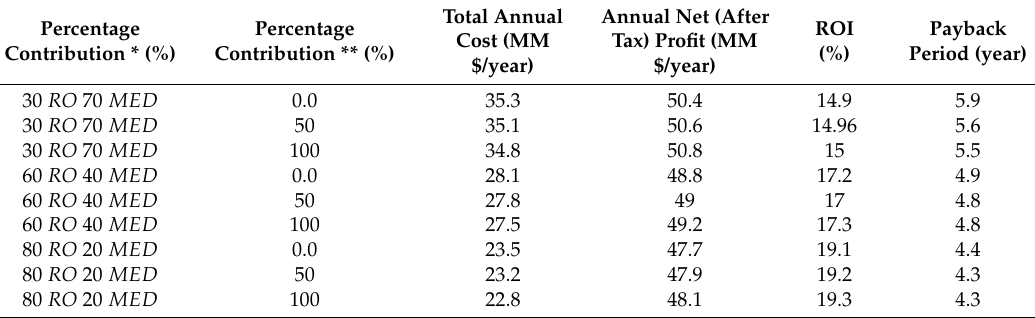
Table 4. Technical and economic results for the